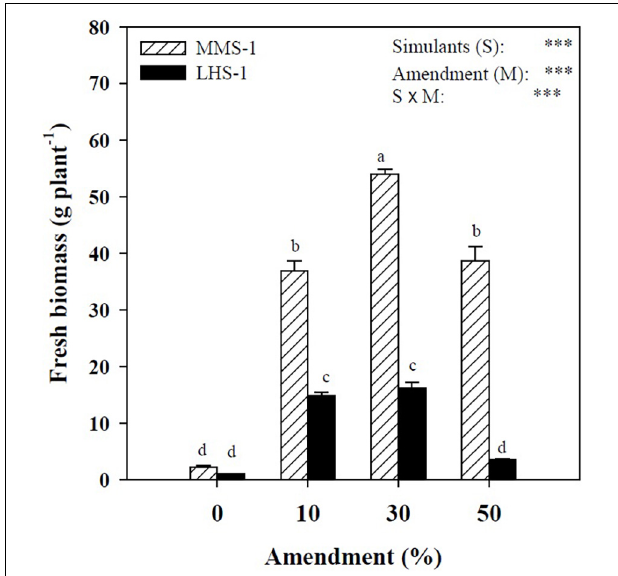
FIGURE 1 | Fresh biomass of lettuce grown in different mixtures of MMS-1 or LHS-1 simulants and manure (simulant/manure rates: 100:0, 90:10, 70:30, 50:50; w/w).